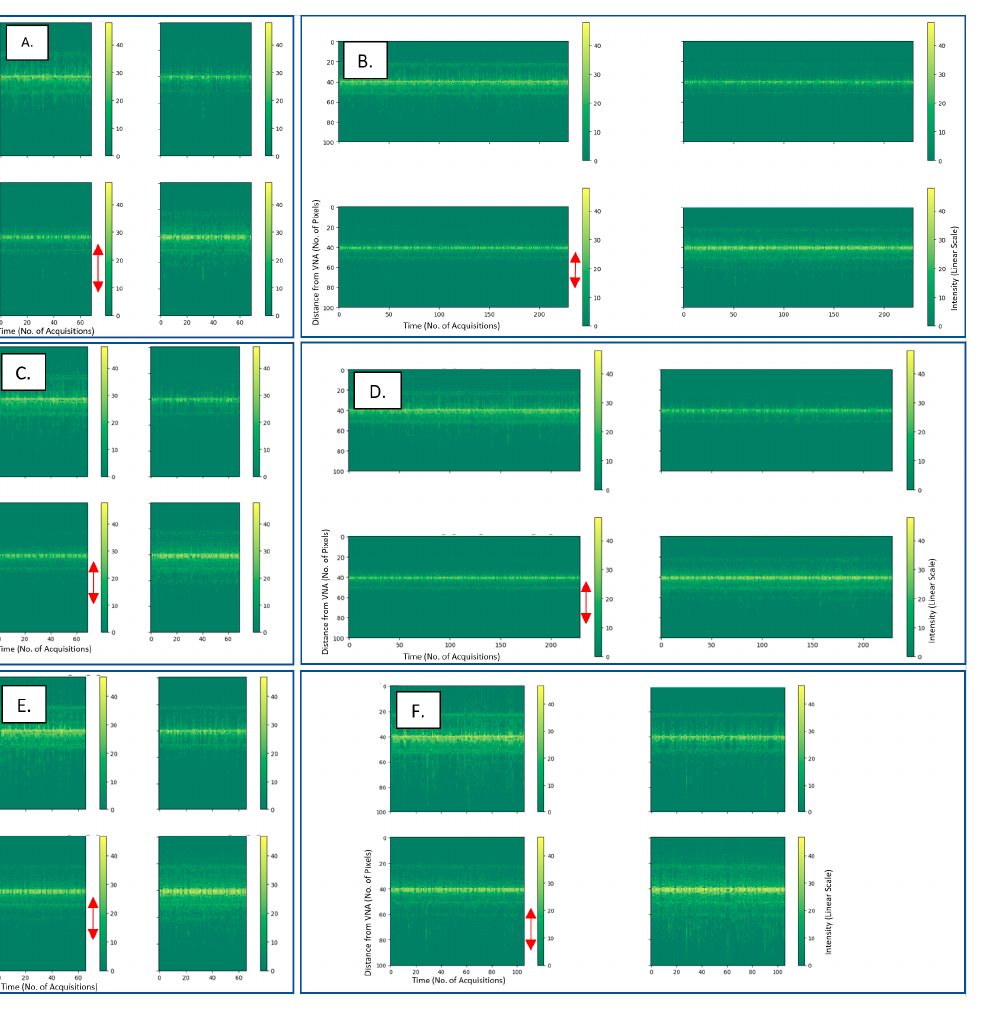
Figure 7. C-band intensity plots of irregular wave reference acquisitions (Left) and test acquisitions (Right). Nine centimetre irregular wave conditions for reference ( A ) and test ( B ) (Top). Test = 40 g/m 2 of plastic bottles inside tank (2 bottles/m 2 ) (Middle). Nine centimetre irregular wave conditions for reference ( C ) and test ( D ) conditions. Test = 20 g/m 2 of plastic foam cylinders (20 cm long) inside tank (Bottom). Seventeen centimetre irregular wave conditions for reference ( E ) and test ( F ) conditions. Test = 10 g/m 2 of plastic lids inside tank (1.5 lids/m 2 ). On each plot: (Top Left) HH Polarisation, (Top Right) VH Polarisation, (Bottom Left) HV Polarisation, (Bottom Right) VV Polarisation. Peak of intensity from the lip of the bridge by radar set-up can be seen across all figures. Colour—intensity on a linear